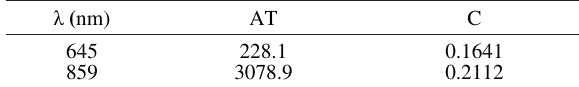
Table 2. – AT and C (FNU) coefficient calibration for the bands 645 and 859 nm MODIS-Aqua. Dogliotti et al. (2011). λ ( nm)